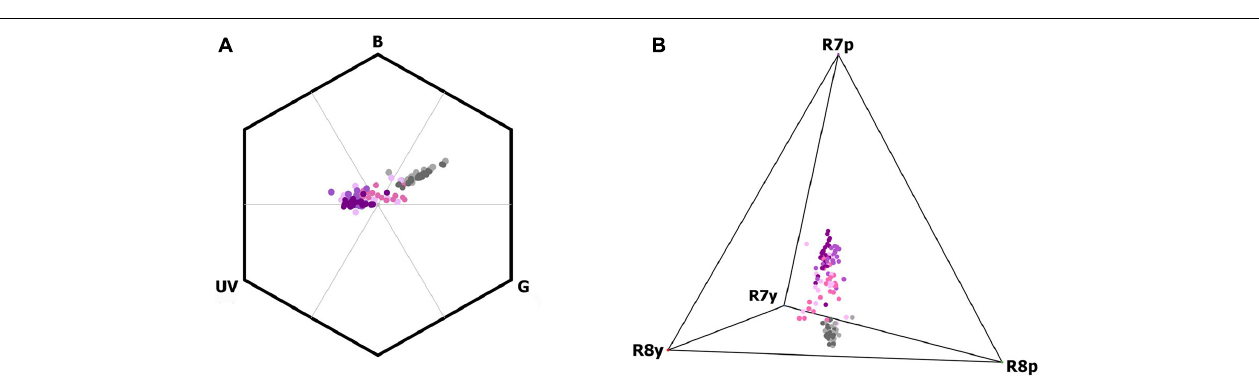
FIGURE 3 | Plotting of Neotinea ustulata samples based on floral morphology traits in PC1 and PC2. Different symbols represent different varieties and ellipses display 95% confidence area of each variety. Different symbol colors represent different populations. Population codes as in Supplementary Table 1 .